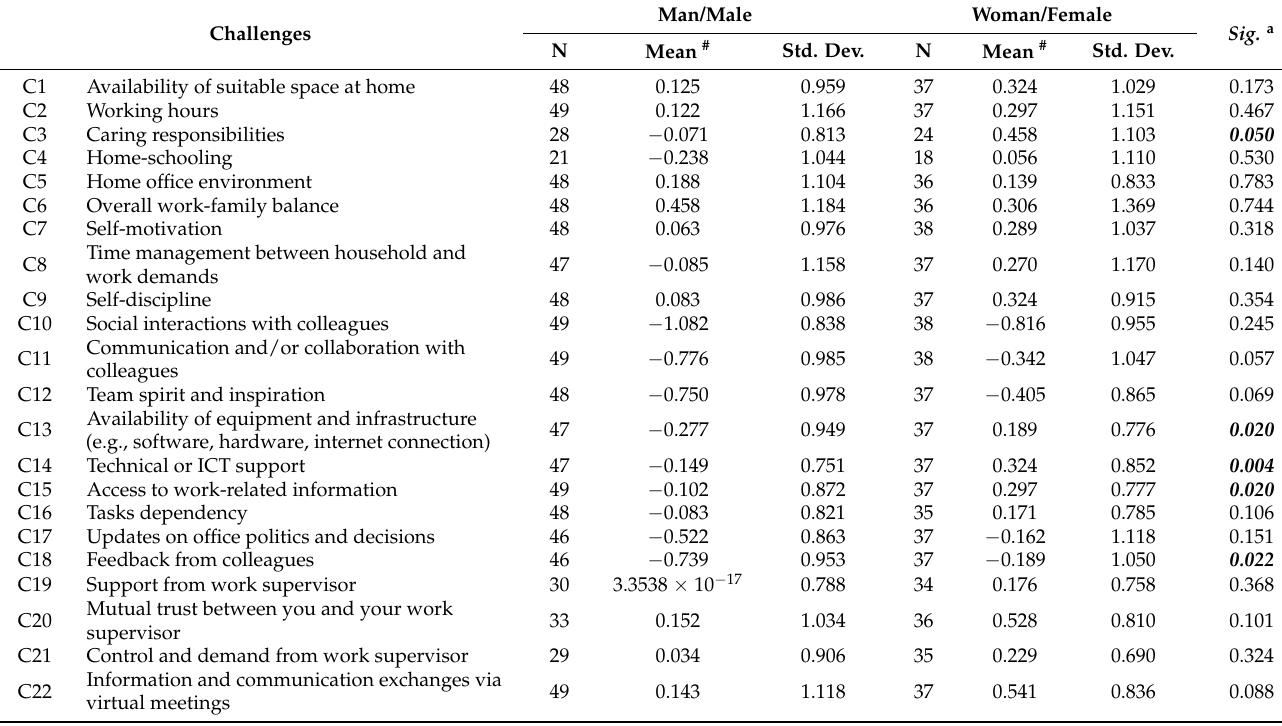
Table 4. The perceived impacts of challenges associated with WFH on work activities and perfor- mance according to